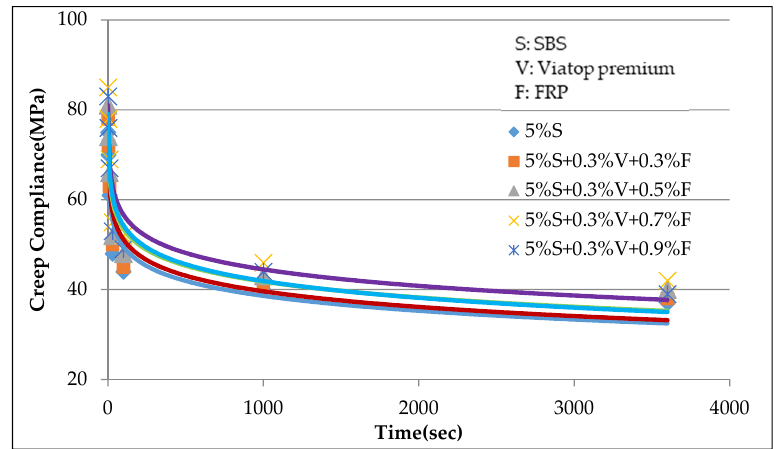
Figure 11. Creep modulus-time relationship.